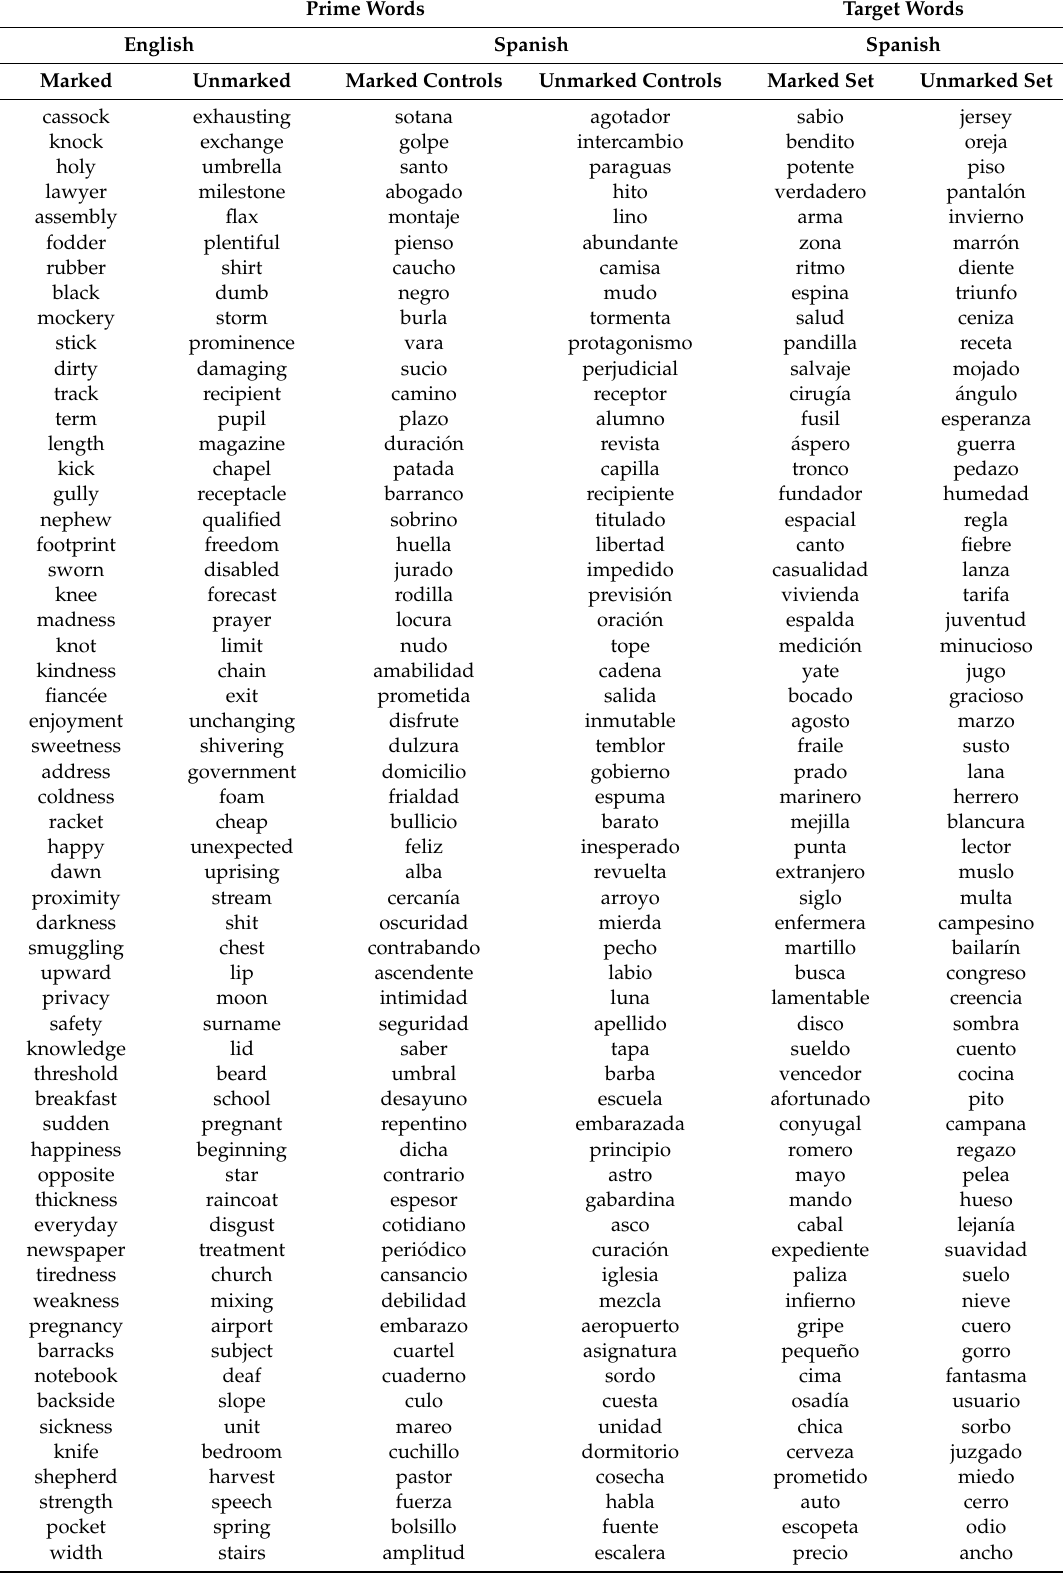
Table A2. Stimuli used in Experiment 2 using the masked language switching priming paradigm with highly proficient Spanish–English